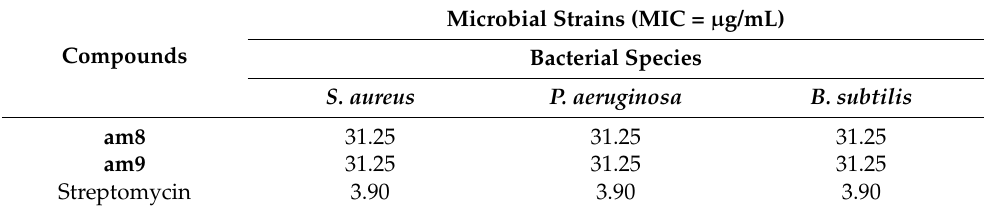
A new series of thiazolidine-2,4-diones containing a 1,2,3-triazole scaffold were syn- thesized by Sindhu et al. and evaluated for their in vitro antimicrobial potential against